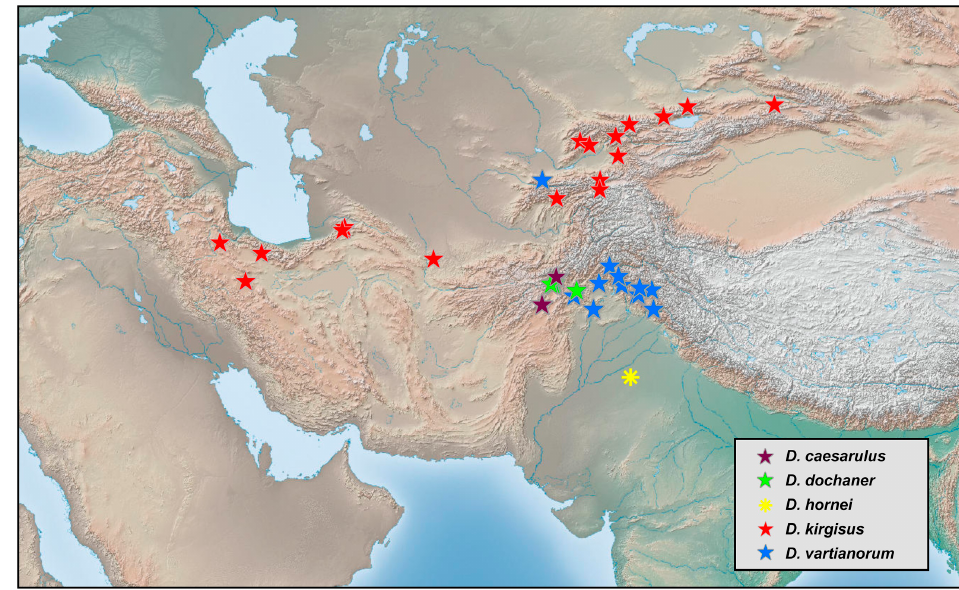
Figure 21. Distribution map of the species of Dilar from Central Asia (Region 2 in Figure 19).